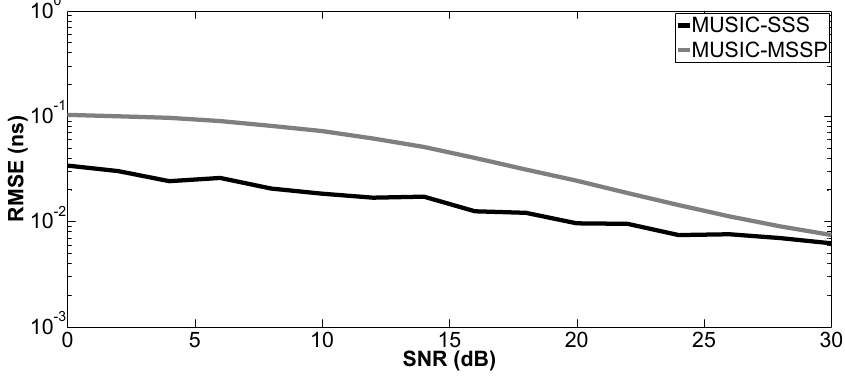
Figure 7. RMSE on the estimated time delay ˆ t 3 versus SNR.